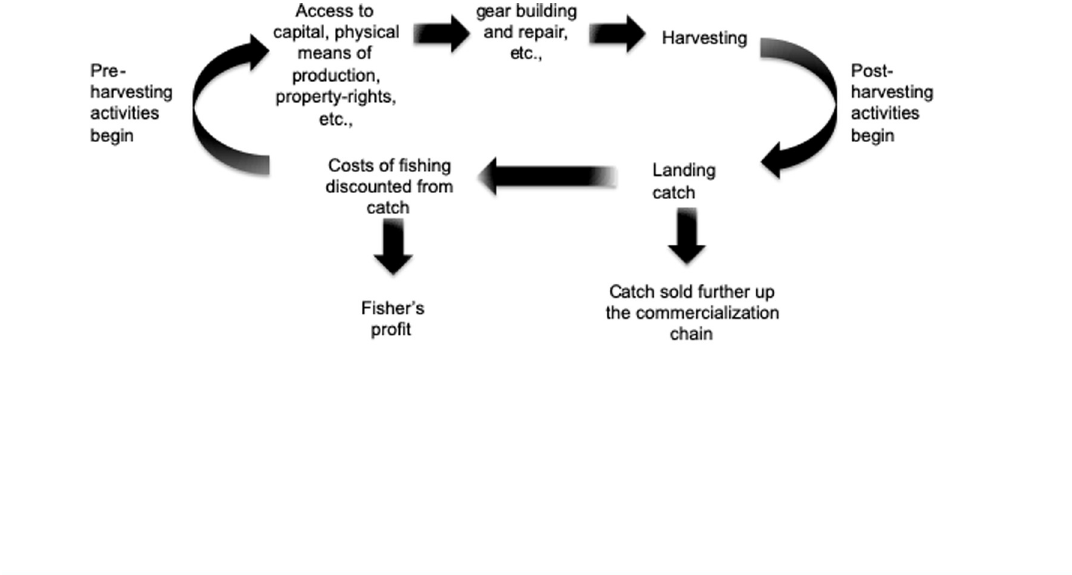
Fig 2. Governing the commons beyond harvesting. Governing the commons beyond harvesting requires incorporating pre-harvesting and/or post-harvesting into analyses of harvesting action-situations. The pre and post-harvesting action situations shown here are not exhaustive. This circular representation highlights the repetitive nature of a ‘typical’ fishing event with implications for the development of trust among fishers and fish buyers. Not all of these action arenas take place every day, nor are networks of action situations necessarily linked in a linear fashion as the diagram could be